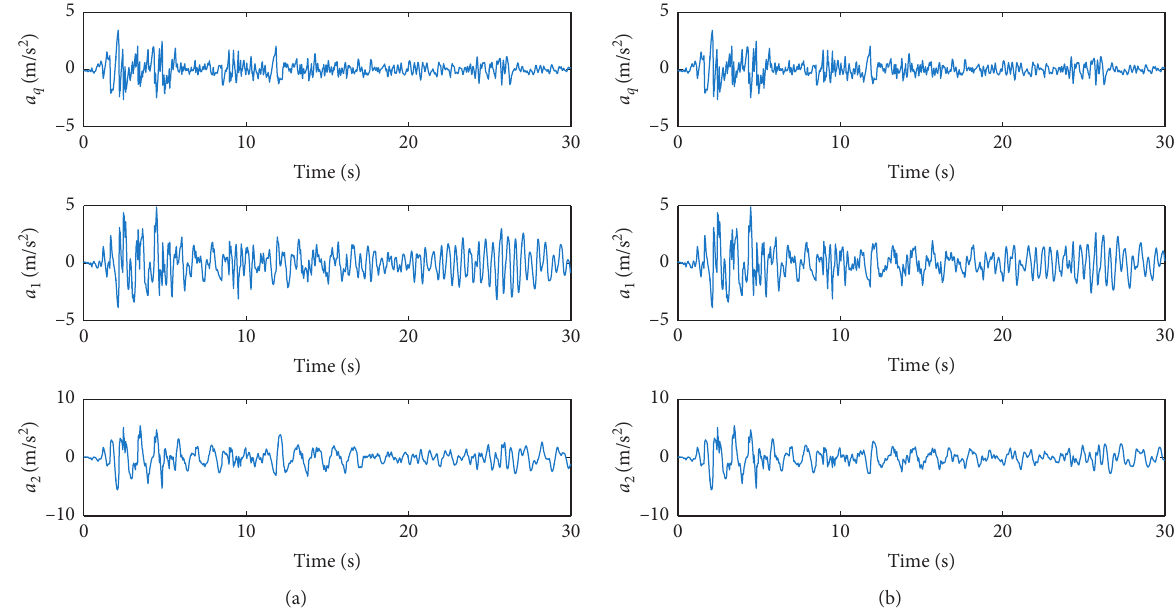
Figure 10: Original acceleration responses of the simulated structure under El-Centro earthquake wave. (a) Case 1. (b) Case 2.